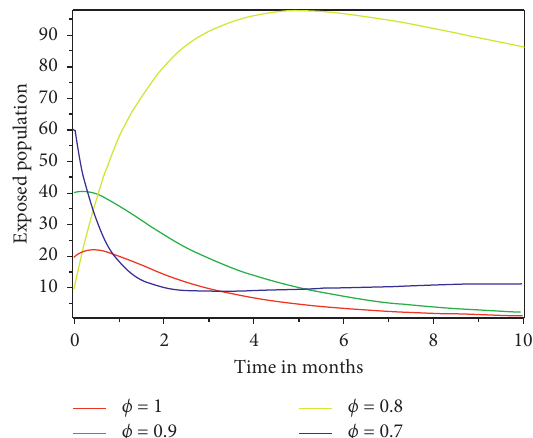
Figure 2: Approximate solution of exposed cows.